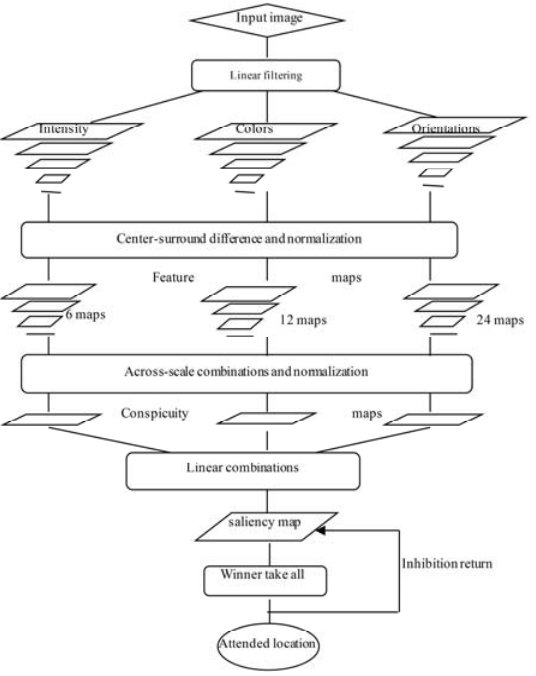
Fig.1 General structure of the visual attention